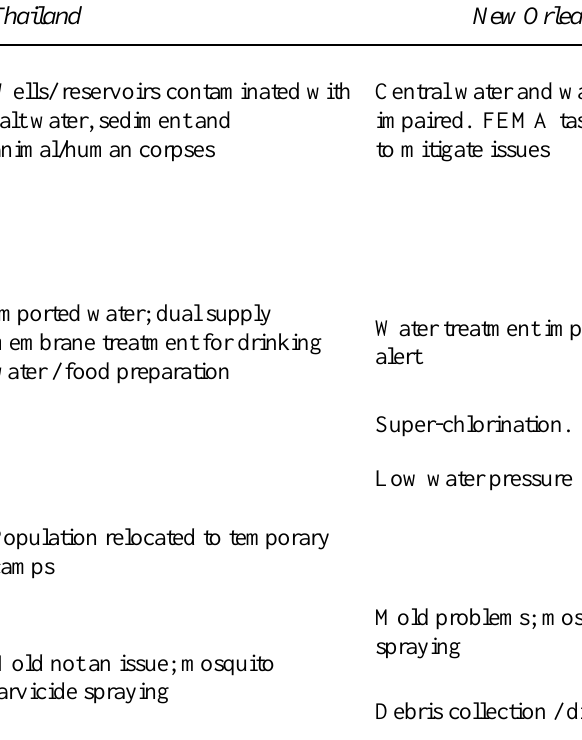
Table 2: General Disaster Impact Areas - Environmental Issues